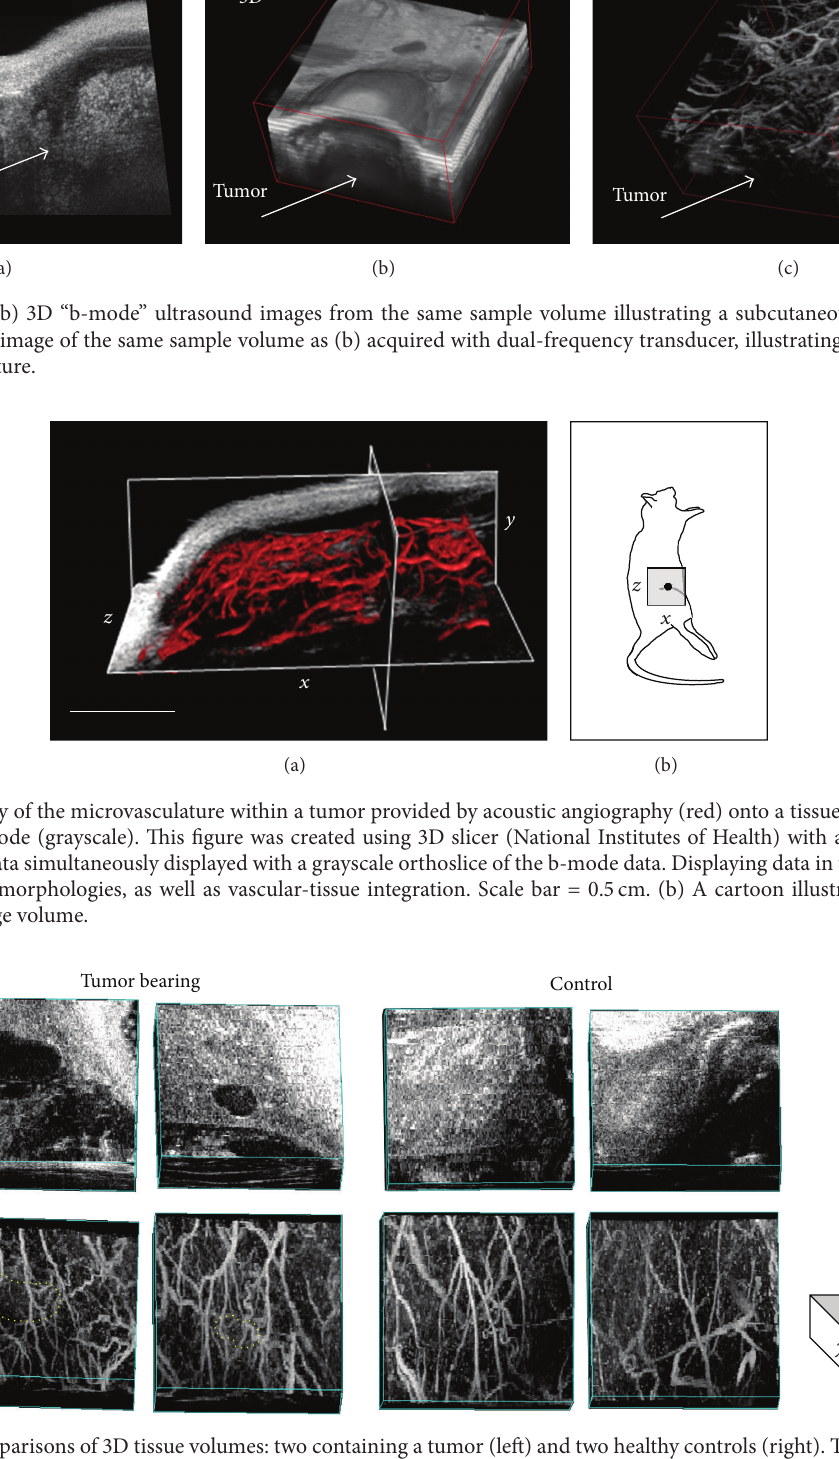
Figure 6: Multiple comparisons of 3D tissue volumes: two containing a tumor (left) and two healthy controls (right). The bottom images are acoustic angiography maximum intensity projections, while the top images are b-mode acquisitions of the same tissue volumes. The tortuous and chaotic morphologies of the vessels in the presence of a lesion are contrasted by the relatively homogeneous vasculature in the healthy volume (tumor boundaries delineated in acoustic angiography image with dotted line). Image volumes = ∼ 0.75 × 1.25 × 1.5cm (axial, lateral, and elevational). A cartoon on the right indicates the imaging location and orientations of image